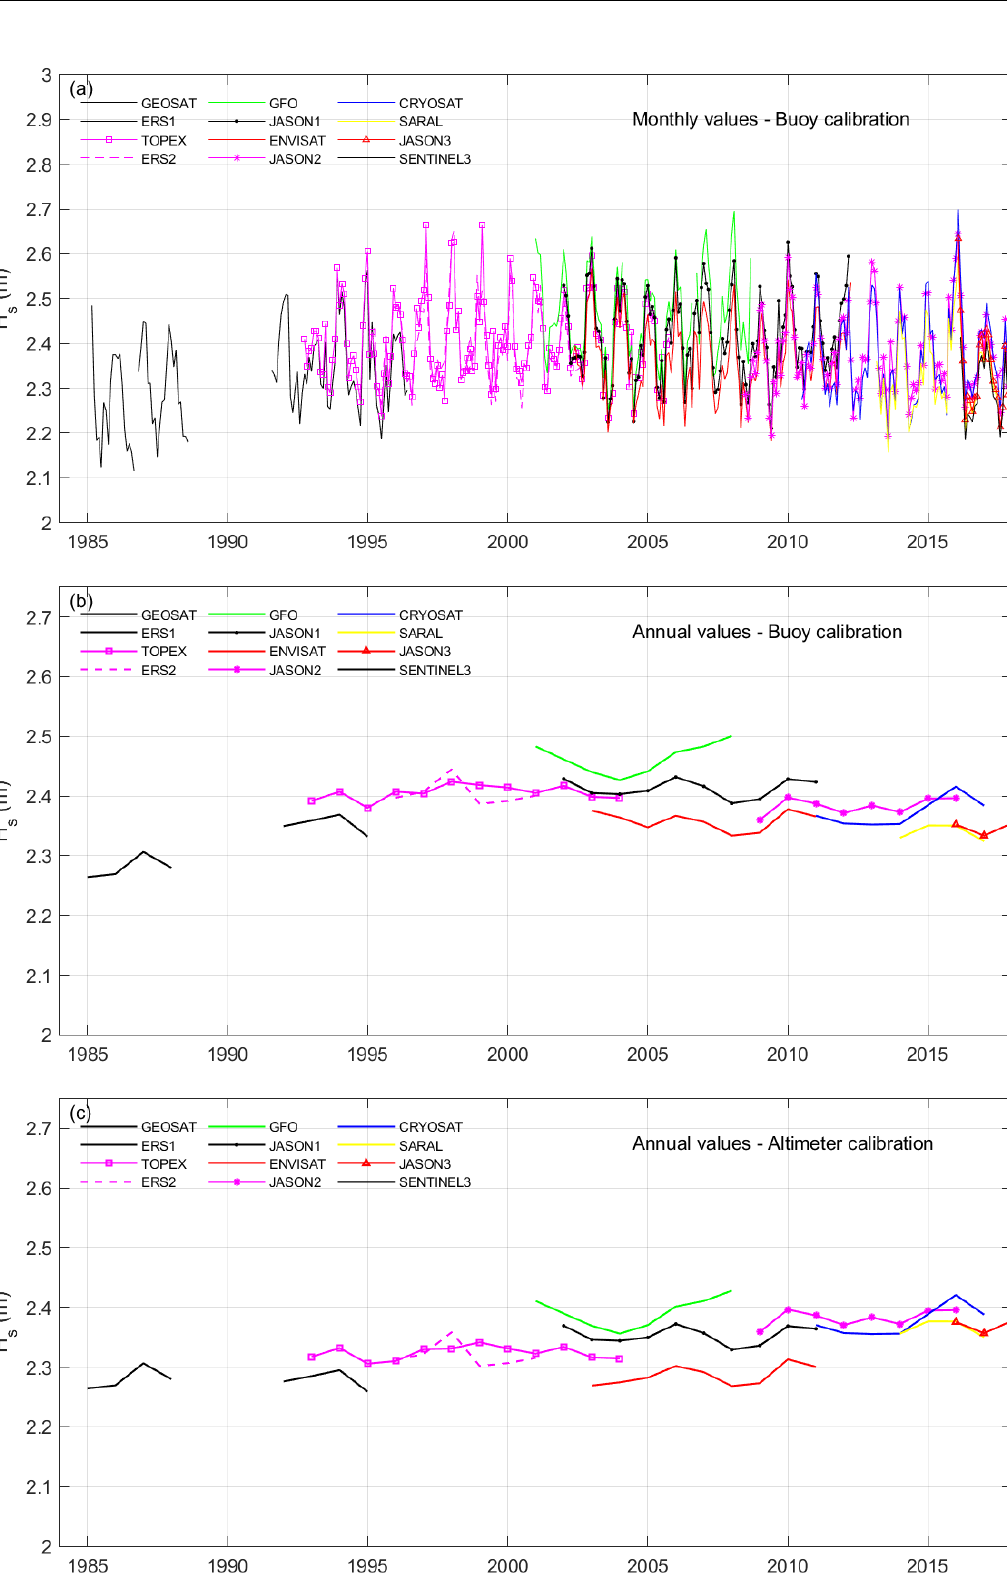
Figure 6. Global ( − 60 ◦ to 60 ◦ ) average values of significant wave height, H s as a function of time. ( a ) Monthly mean values for the “altimeter–buoy” calibration, ( b ) Annual mean values for the “altimeter–buoy” calibration, ( c ) Annual mean values for the “altimeter–altimeter” calibration. Note: for plotting convenience, a different scale exits in panels ( b , c ) compared to ( a ).